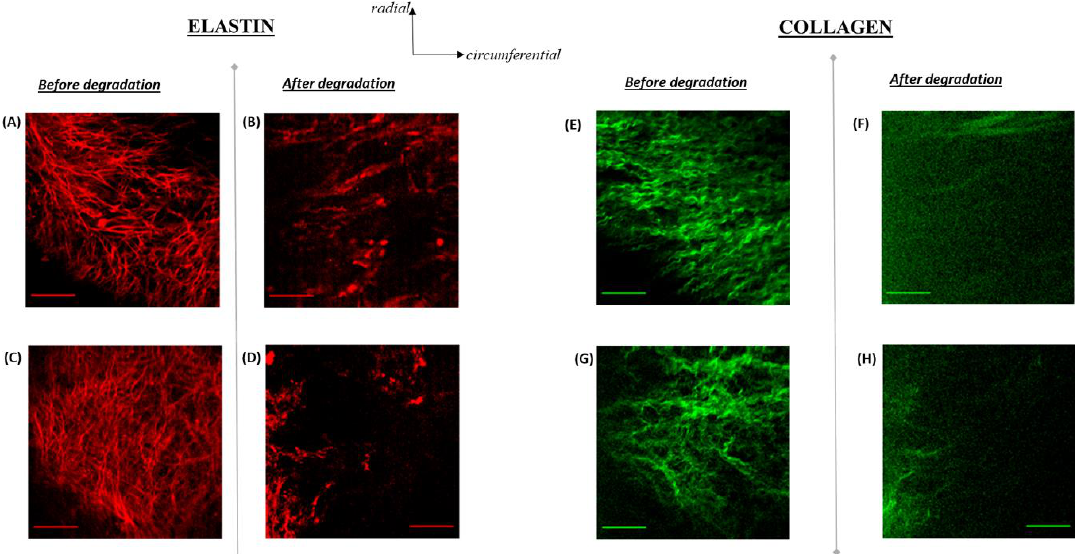
Figure 4 . ( A – D ) Elastin structure in aortic valve leaflets before ( A , C ) and after ( B , D ) elastase- degradation. Images ( A ) and ( B ) were obtained from the non-coronary cusp whereas images ( C ) and ( D ) were from the left coronary cusp. Image sections were taken at a depth of 36 µm from the nearest leaflet surface. Scale bar in all images is 50 µm. Elastin fibers ( A , C ) exhibited a strong affinity for alignment in the radial direction. Enzymatic-degradation clearly led to loss of elastin content, orientation and network in the leaflets ( B , D ). ( E – H ) Collagen distribution at the same spatial location in which Elastin structure was imaged ( A – D ). Collagen fibers ( E , G ) were primarily oriented in circumferential direction. Degradation with elastase enzyme was not specific to elastin as clearly, loss of collagen content, orientation and network in the leaflets also occurred ( F , H ).